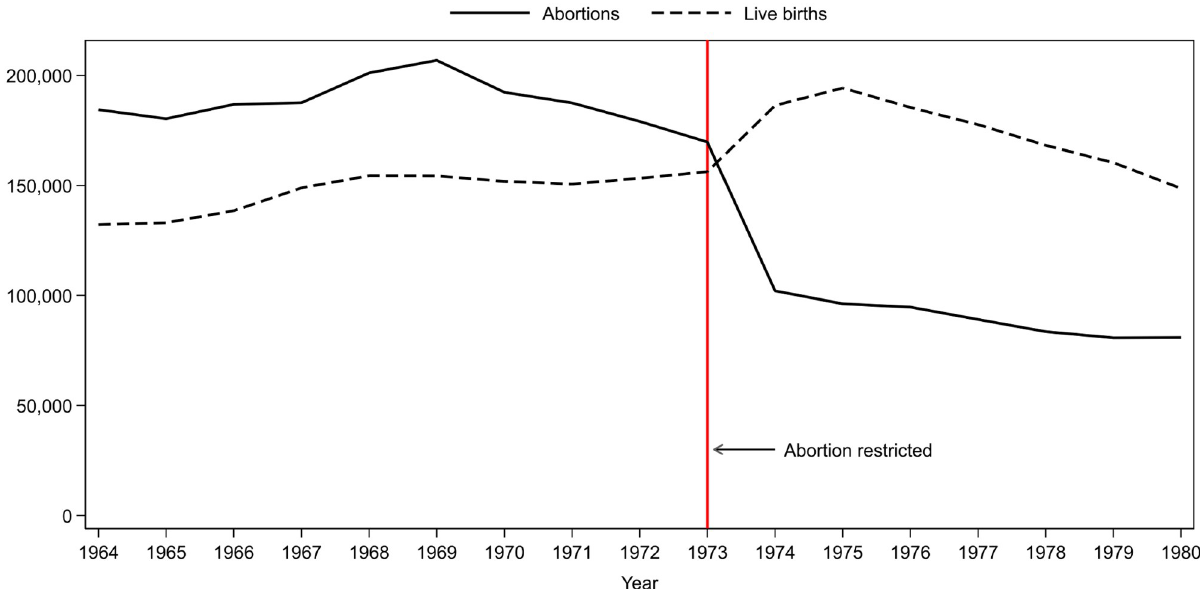
Fig 1. Number of induced abortions and live births between 1964 and 1980. Source: Hungarian Central Statistical Office (http://www.ksh.hu/docs/ eng/xstadat/xstadat_long/h_wdsd001a.html and http://www.ksh.hu/docs/eng/xstadat/xstadat_long/h_wdsd001b.html).